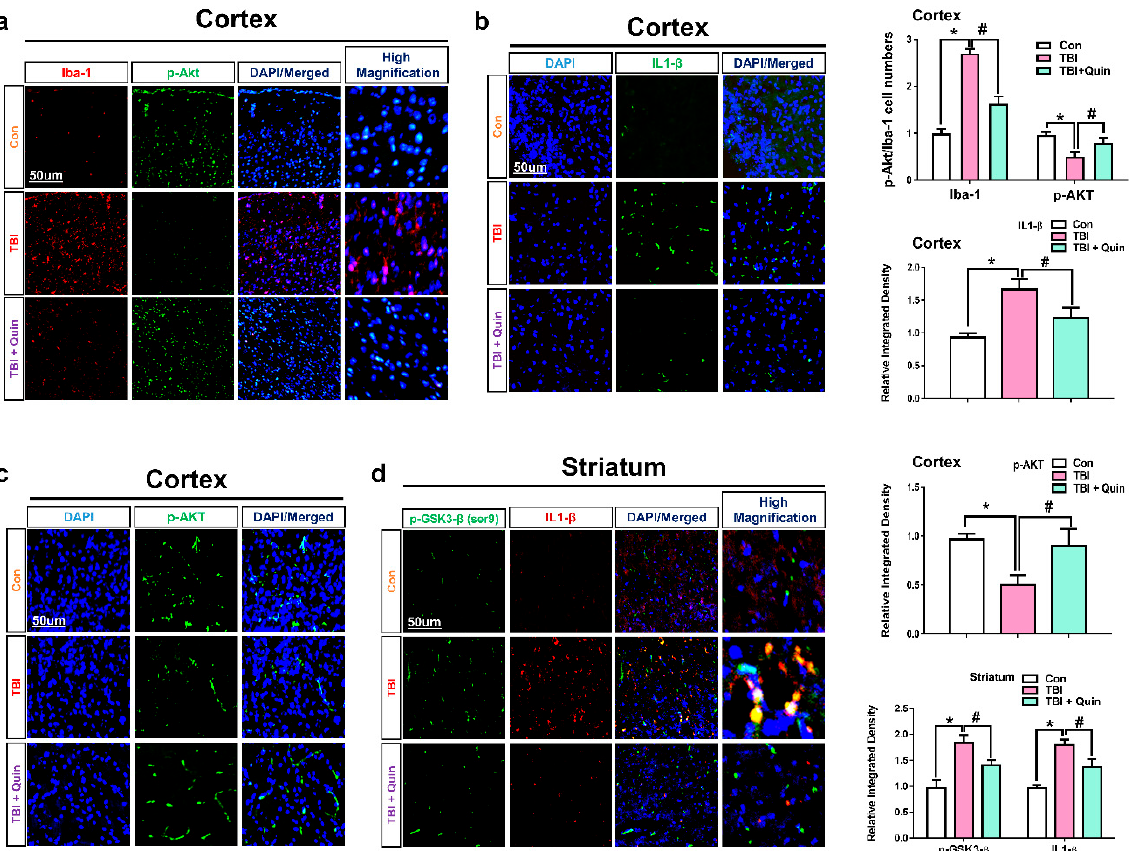
Figure 2. Quinpirole treatment reduces neuroinflammation via activation of the iba-1/p-Akt/p-GSK3- β and IL1- β signaling pathways after brain injury. ( a ) Double IF images of iba-1 and p-Akt in the ipsilateral cortex of brain-injured and quinpirole-treated mice. ( b , c ) Images showing results of immunofluorescence testing p-Akt (ser9) and IL1- β in the ipsilateral cortex after brain injury. ( d ) Images showing double immunofluorescence of p-GSK3- β (ser9) (FITC-label, green) and IL1- β (TRITC-label, red) (DAPI-label, blue) in the ipsilateral striatum with respective bar graphs, (magnification × 10, n = 6). Data were obtained after following three independent experiments. The ImageJ software was used for quantitative analysis of the confocal microscopy images and the maximum fluorescent intensity in the representative field was taken. Values are expressed as mean ± SEM. We performed the one-way ANOVA test followed by post-hoc analysis. A p value < 0.05 was considered statistically significant. * significantly different between control and brain injury groups, # significantly different between the brain injury and quinpirole-treated groups. ANOVA: analysis of variance, FITC: fluorescein isothiocyanate, GSK3- β : glycogen synthase kinase 3 beta, IL: interleukin, SEM: standard error of mean, TRITC: